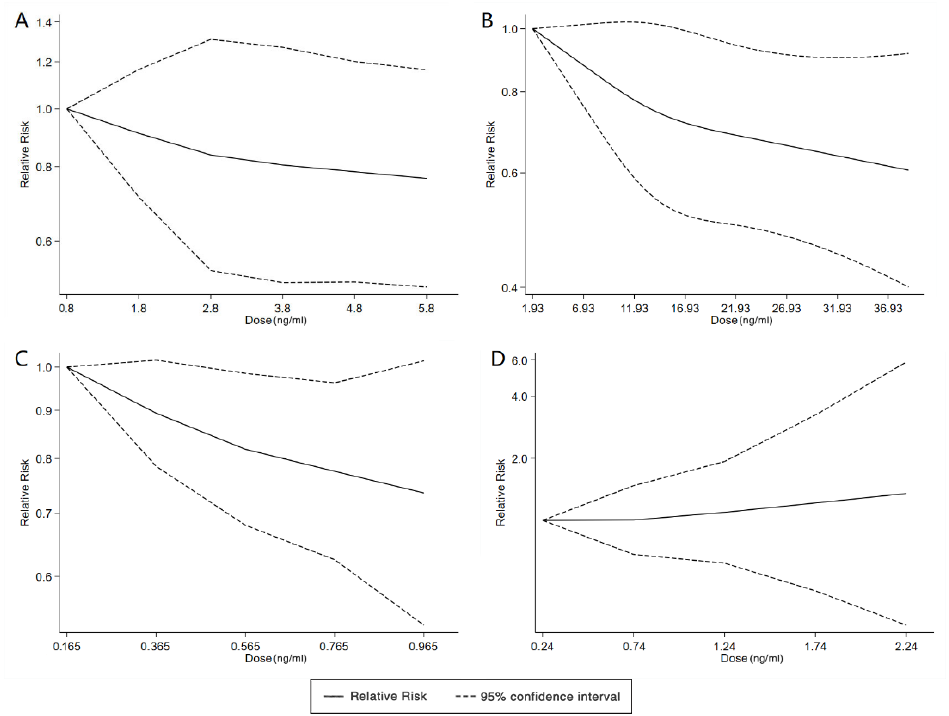
Figure 7. Dose–response relationship between polyfluoroalkyl substances and the risk of ASD. ( A ): PFOA; ( B ): PFOS; ( C ): PFNA; ( D ): PFHxS. Abbreviations: PFOA, perfluorooctanoate; PFOS, perfluorooctane sulfonate; PFNA, perfluorononanoate; PFHxS, perfluorohexane sulfonate; ASD, autism spectrum disorders.